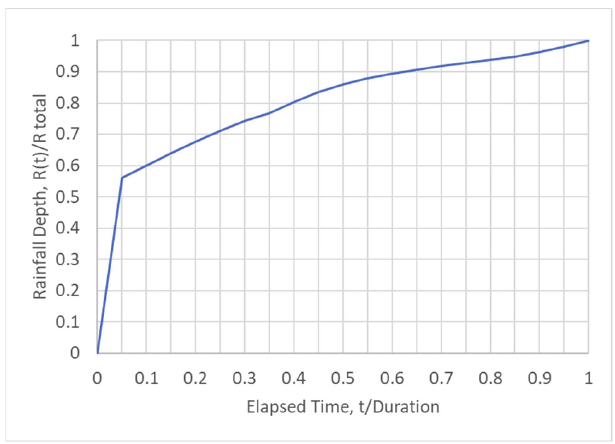
Figure 10. Dimensionless cumulative hyetograph, first quartile for Jeddah City (Elfeki et al., 2014). Based on this dimensionless cumulative hyetograph, maximum daily rainfall data recorded by rainfall stations J ‐ 104 and J ‐ 214 (Table 2) are processed to develop hyeto ‐ graphs. Rainfall data with zero (0) rainfall are not required to be processed, and these increment hyetograph data will be inputted as rainfall during the surface water modeling stage. 4.2. Surface Water Modeling Before performing surface water modeling, the first thing to do is delineate the wa ‐ tershed boundary using WMS. This watershed has a morphometric characteristic that WMS automatically exports this data for surface water modeling in HEC ‐ HMS. Then, it requires delineation of the alluvium inside the watershed. This step is done in the Google Earth application, where the actual surface condition can be seen; thus, al ‐ luvium delineation can be appropriately estimated. The result of this delineation is the separation between alluvium and rock boundaries (Figure 11). The total area of alluvium is 130.80 km 2 (14.52%) and rock is 770.35 km 2 (85.48%). Figure 11. Alluvium and rock delineation in Al ‐ Lusub watershed.